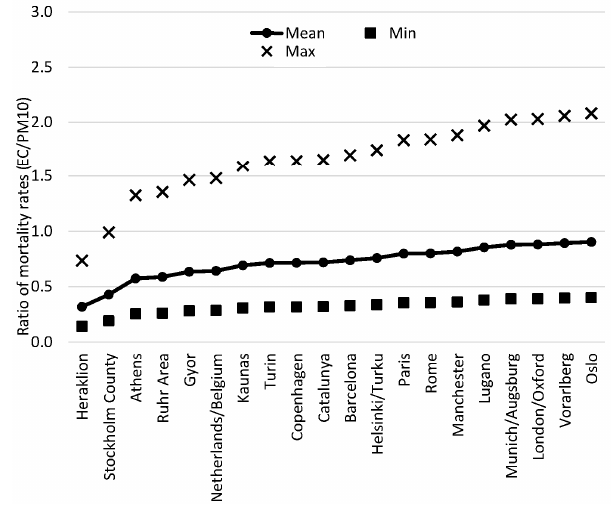
Figure 3. The ratio of relative increase in all-cause mortality associated with short-term exposure to measured levels of PM 10 vs. exposure to our calculated concentrations of EC, derived from measured concentrations of PM 10 and Abs at some urban background locations in Europe. The calculations are based on a 0.68% increased mortality per 10 μ g·m − 3 ·BS. The EC content is estimated to be 12% in BS (minimum 5.2% and maximum 27%, see text).